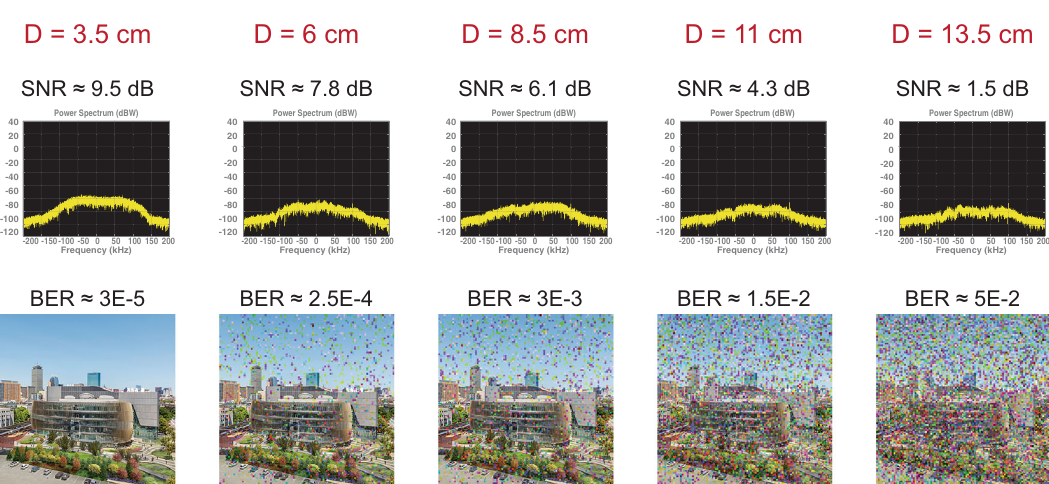
Fig. 4 Communication results. The ultrasonic channel is tested for Signal-to-Noise Ratio (SNR) and bit error rate (BER) at several implantation depths ranging from 3.5 cm up to 13.5 cm. Furthermore, the BER can be directly visualized with the transmitted data, the image of Northeastern University campus, in terms of lost or wrong pixel colors. Measurements are done between two LN pMUT arrays implanted in the tissue phantom shown in Fig.